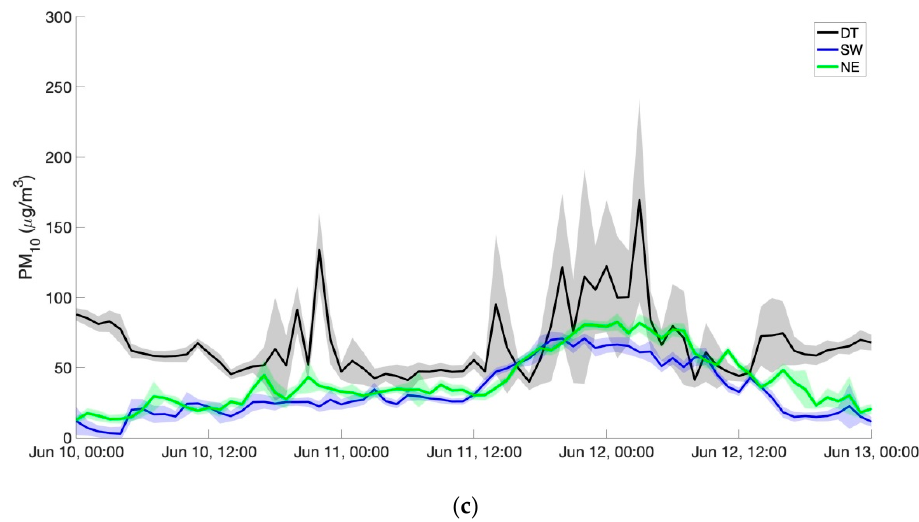
Figure 8. Air mass trajectory and PM concentrations in the three locations during 10–13 June period ( a ) NOAA-HYSPLIT model results. The colored lines represent the following arrival times: sky blue—10 June at 12:00, green—11 June at 00:00, blue—11 June at 12:00, and red—12 June at 00:00; ( b ) hourly PM 2.5 ; ( c ) hourly PM 10 .